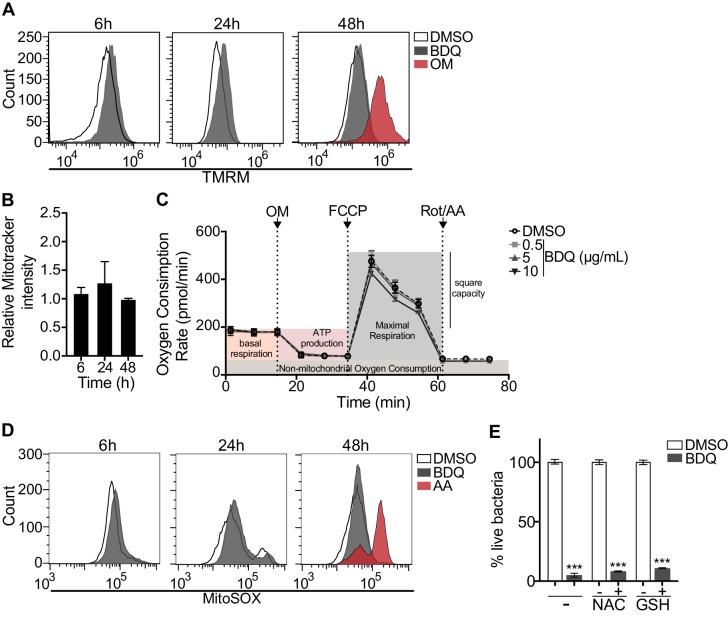
BDQ does not affect mitochondrial functions.(A) Macrophages were treated with BDQ for 6, 24 and 48 hr and incubated with TMRM. Fluorescence was quantified by flow cytometry. Oligomycin (OM) is a positive control. (B) Cells were treated as in (A), and mitochondria were stained with MitoTracker Red FM. The graph represents the ratio between the mean fluorescence intensity of BDQ-treated cells and DMSO-treated cells. (C) Oxygen consumption rate (OCR) measured by Seahorse extracellular flux assay of cells incubated with BDQ for 24 hr. Basal respiration, ATP production, maximal respiration, respiratory reserve, and nonmitochondrial respiration were followed by sequential additions of oligomycin (OM, an inhibitor of the ATPase), the mitochondrial oxidative phosphorylation uncoupler FCCP, and the inhibitors of electron transport rotenone/antimycin A (Rot/AA). Error bars represent the mean ± SD of three technical replicates. One representative experiment (of two) is shown. (D) At each indicated time points, mitochondrial superoxide (mROS) were stained using the MitoSOX dye in BDQ-treated cells. Antimycin A (AA) is used as a positive control. (E) Cells were incubated with BDQ in the presence or not of two antioxidants, glutathione (GSH) and its precursor N-Acetyl-L-cysteine (NAC). After 24 hr, the cells were infected with S. aureus for an additional 24 hr. Macrophages were lysed and the number of intracellular bacteria enumerated. One representative experiment (of three) is shown. Error bars represent the mean ± SD. was used. ***p<0.001.